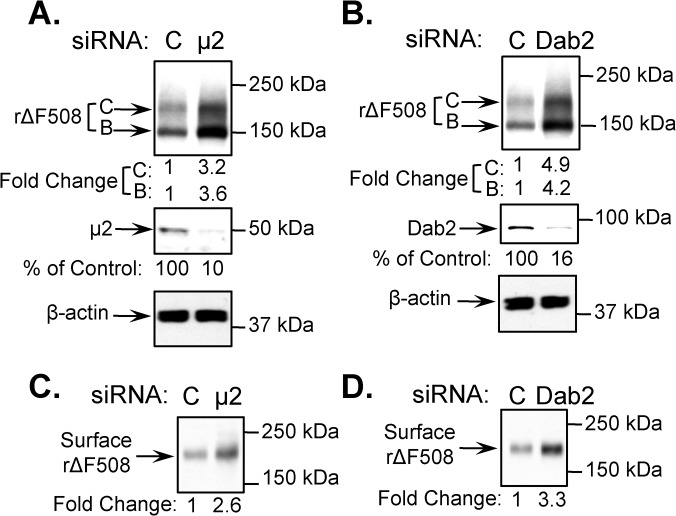
Increased cell surface expression of rescued ΔF508 CFTR (rΔF508 CFTR) following μ2 and Dab2 depletion.The consequences of μ2 depletion and Dab2 depletion on total ΔF508 CFTR expression (A and B) and on surface rΔF508 CFTR expression (C and D). CFBE41o-ΔF cells were transfected with 20 nM siRNA duplexes targeted specifically to μ2 or Dab2 or control (C) siRNA. 48 h after transfection, the control and siRNA depleted cells were cultured for an additional 24 h at 27°C to promote ΔF508 CFTR delivery to the cell surface. 72 h after transfection, 25 μg of cell lysates were separated by SDS-PAGE and immunoblotted using anti-CFTR, anti-μ2 and anti-Dab2 antibodies. β-actin was blotted as loading control. The changes in μ2, Dab2 and rΔF508 CFTR levels following siRNA depletion are indicated below the blots. Cell surface expression of rΔF508 CFTR was monitored by biotinylation as described in the Experimental section. The molecular mass in kDa is indicated on the right-hand side of each panel.